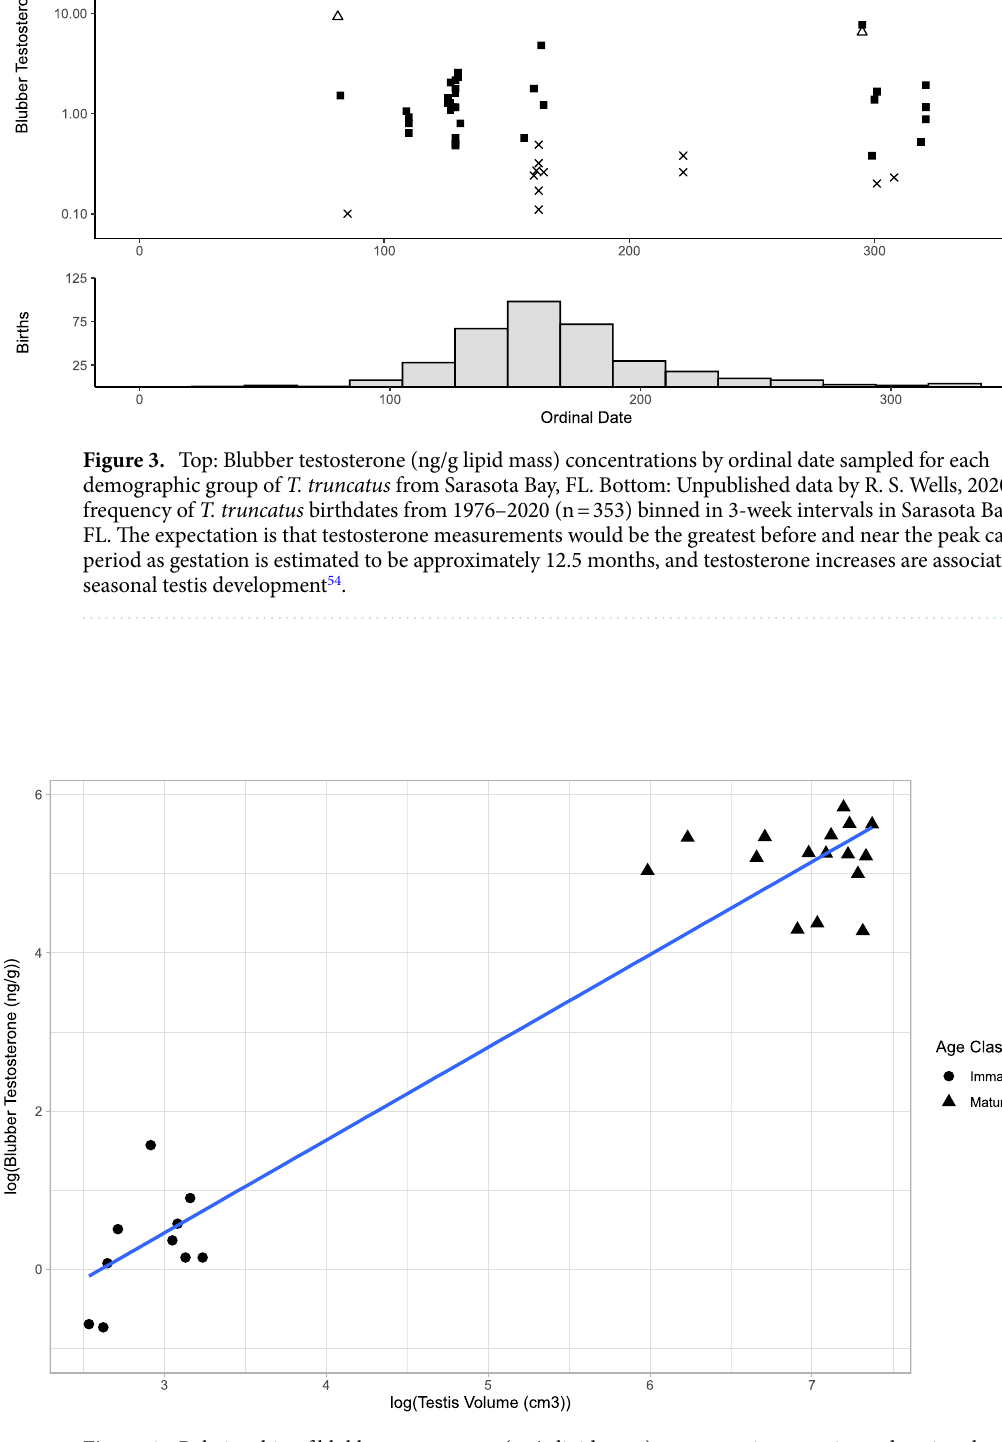
Figure 4. Relationship of blubber testosterone (ng/g lipid mass) concentration to estimated testis volume (cm 3 ) for mature and immature male T. truncatus from Sarasota Bay, FL (r 2 = 0.936, p = 7.977 × 10 –16 , y = 1.173*x +